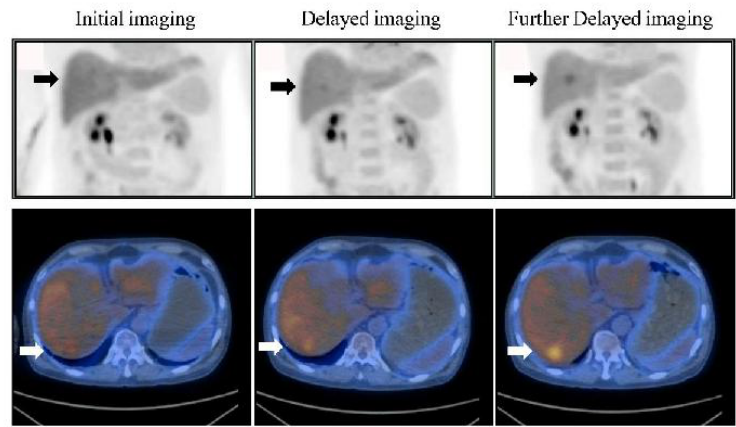
Figure 3. Liver metastases were detected only on delayed FDG PET / CT imaging. Liver FDG maximum-intensity projection (top row) and axial FDG PET / CT imaging (bottom row) of initial (left), delayed (middle) and further delayed imaging (right) in a 60-year-old-male patient with colon cancer displayed an FDG-avid liver lesion that was detected only on delayed and further delayed imaging but not on initial imaging (arrows). There was more evidence of the liver lesion and increased contrast against normal liver tissue on further delayed imaging as compared with delayed imaging. Pathology confirmed metastatic adenocarcinoma originating from the colon.